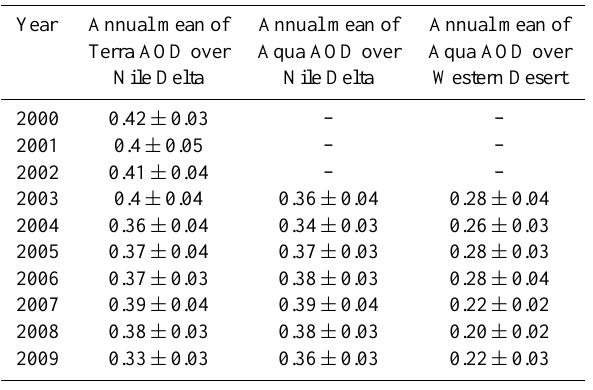
Table 1. Annual AOD means for both Terra and Aqua over Nile Delta and for Aqua Deep Blue over the Western Desert of Egypt.